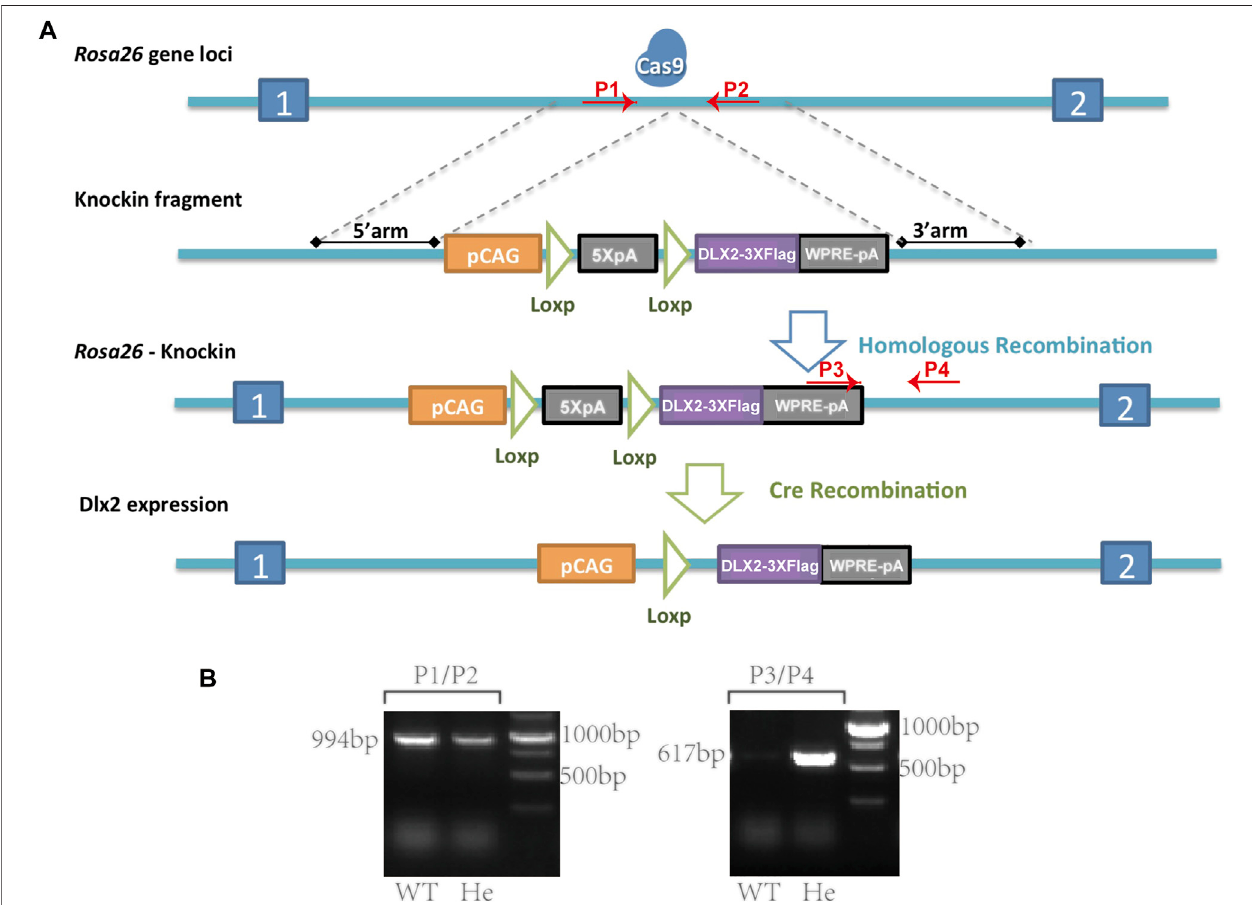
FIGURE 1 | A Rosa26 CAG-LSL-Dlx2 − 3xFlag mouse model for conditional Dlx2 overexpression (A) Cartoons illustrate the design strategy for conditionally overexpressing Dlx2 by breeding Rosa26 CAG-LSL-Dlx2 − 3xFlag mice with Cre mice (B) In WT mice (P1, P2) generated a 994 bp band, whereas (P3, P4) did not generate a PCR product. In heterozygous mice (P1, P2) ampli fi ed a 994 bp PCR product, while (P3, P4) ampli fi ed a smaller PCR product of 617 bp. Cas9, CRISPR/Cas9 system; pCAG, CAG promoter; 5XpA, 5X PolyA (containing STOP cassette); DLX2-3XFlag, coding sequence of Dlx2 with 3X fl ag; WPRE-pA, woodchuck hepatitis